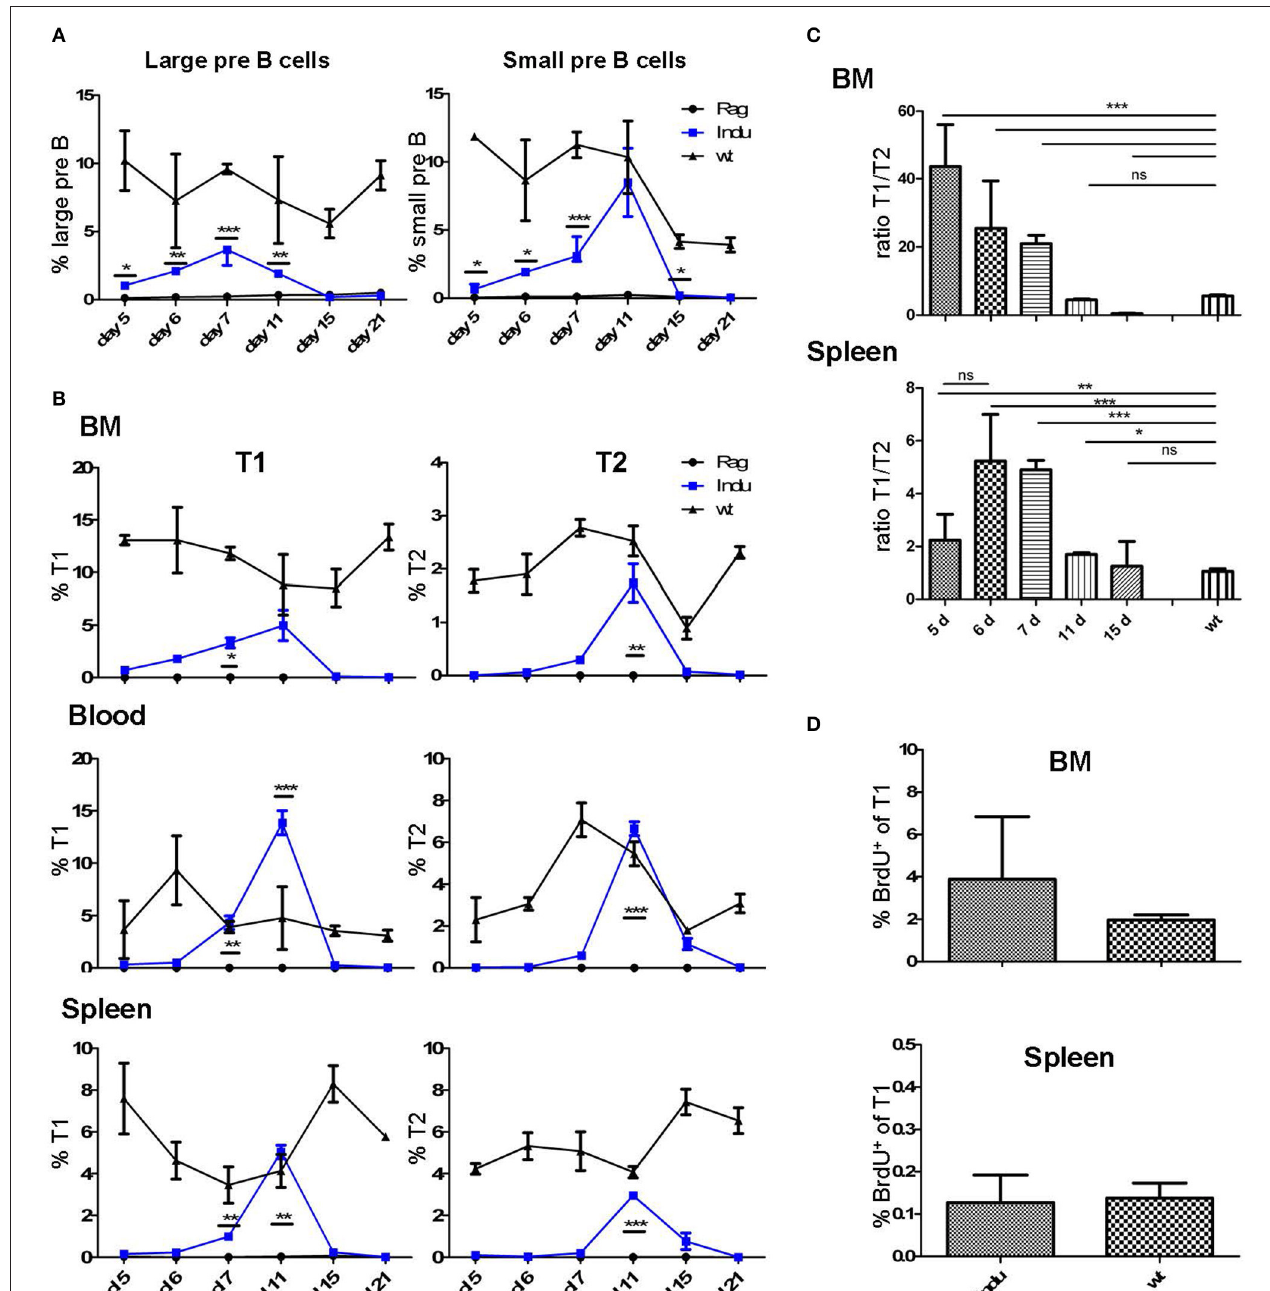
FIGURE 1 | Progenitor and immature B cells after TAM-mediated induction of B cell development in different organs of adult B-Indu-Rag1 mice . (A) Large (left) and small (right) preB-II cells in BM at indicated time points after induction of B lymphopoiesis. (B) Kinetics of transitional B cell (T1 and T2) appearance at different anatomical sites (BM, peripheral blood, spleen) and time points post induction, as indicated. (C) Ratio of B cells with a T1 and T2 phenotype in BM and spleen of B-Indu-Rag1 mice at indicated time points after TAM administration. Note that the T1/T2 ratio of Wt mice is shown for comparison (right bar). (D) Cell proliferation of T1 cells from BM and spleen of TAM-treated B-Indu-Rag1 (left) and Wt (right) mice, as revealed by BrdU incorporation in vivo . Labeling was carried out exactly as described by the vendor. BrdU 2mg was given i.p. 9 days after application of TAM and the incorporation was analyzed 2h later by flow cytometric analysis. (A–D) : Graphs show percentages of indicated B cell populations as median ± SEM ( n ≥ 3 mice); asterisks in graphs indicate the level of significance (see methods for details). The experiments were carried out at least twice.